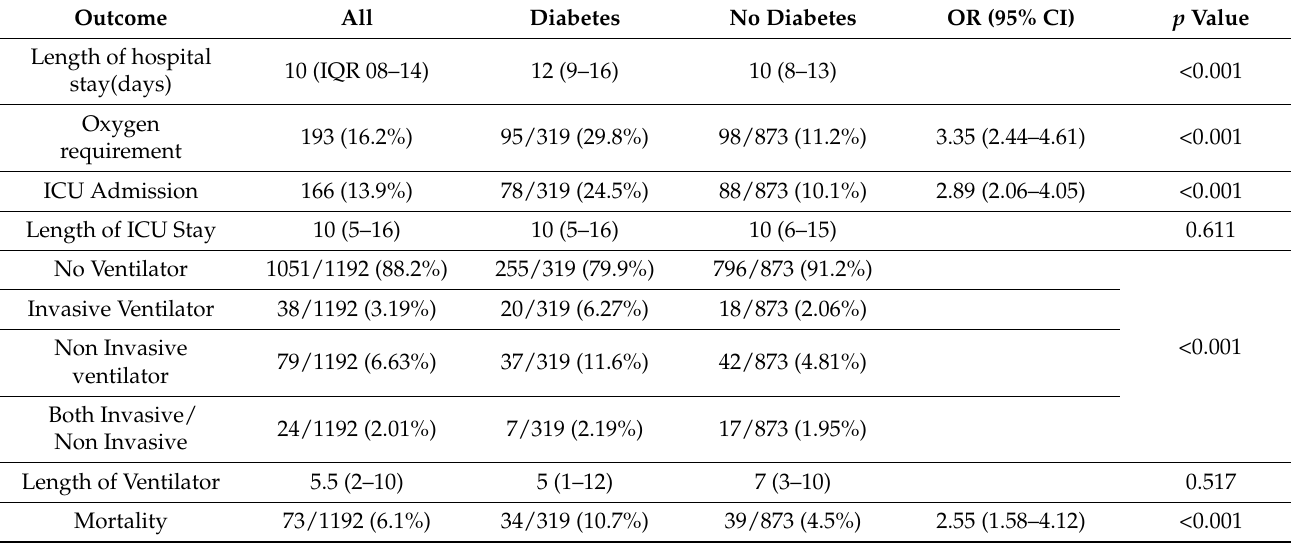
Table 3. Clinical outcome in patients with and without